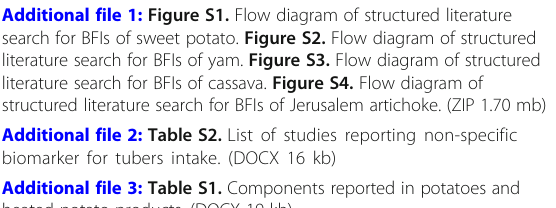
Additional file 1: Figure S1. Flow diagram of structured literature search for BFIs of sweet potato. Figure S2. Flow diagram of structured literature search for BFIs of yam. Figure S3. Flow diagram of structured literature search for BFIs of cassava. Figure S4. Flow diagram of structured literature search for BFIs of Jerusalem artichoke. (ZIP 1.70 mb) Additional file 2: Table S2. List of studies reporting non-specific biomarker for tubers intake. (DOCX 16 kb) Additional file 3: Table S1. Components reported in potatoes and heated potato products. (DOCX 19 kb)